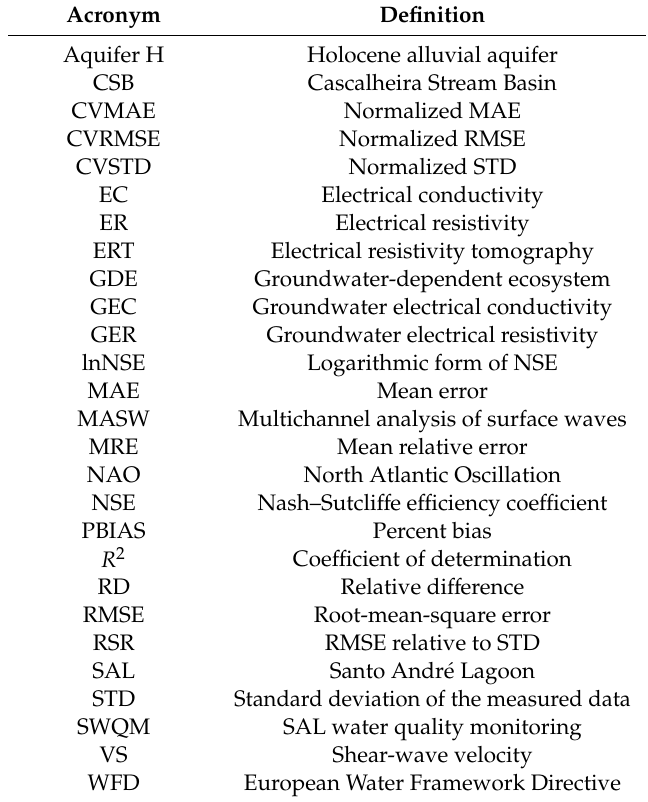
Table 1. Description of acronyms